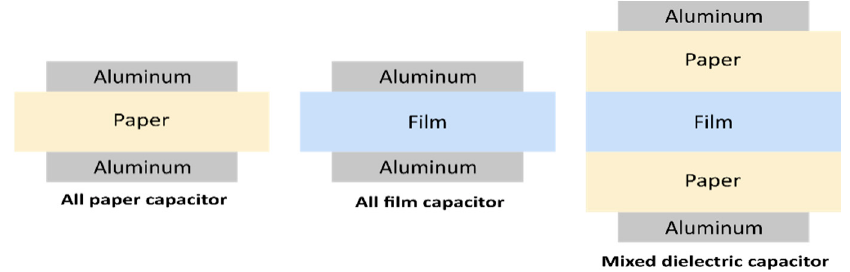
Figure 5. Different types of foil–film capacitors.